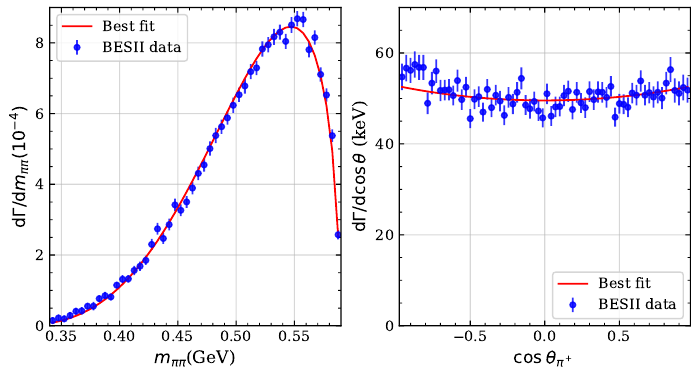
Figure 6: The fit to the BESII data on the ψ ( 2 S ) → J /ψπ + π − transition [ 11 ] with χ 2 / dof = 1.1. Adapted from Ref. [ 3 ] under attribution 4.0 International license (CC BY